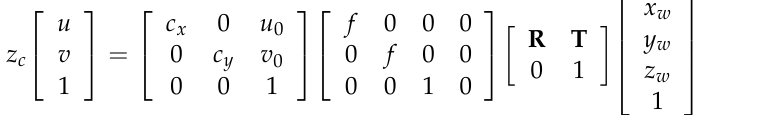
Figure 8. Calibration projection relation of optical imaging system.